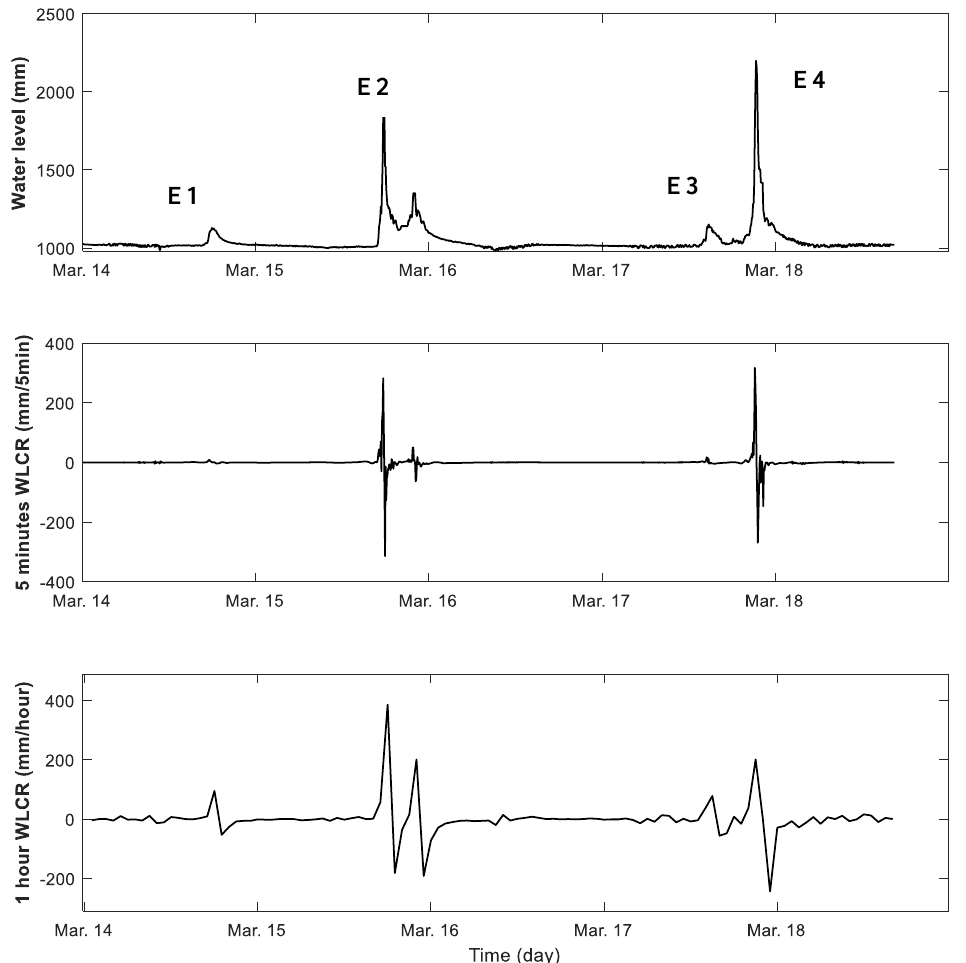
Figure 18. WLCR of 5 days rainfall (14–18 March): ( top ) water level change, ( middle ) WLCR by the 5-min sampling rate, and ( bottom ) WLCR by the 1-h sampling rate. The three graphs showing the WLCR by the 5-min sampling rate show the more sensitive behavior at the higher WLCR case than the 1-h sampling rate.